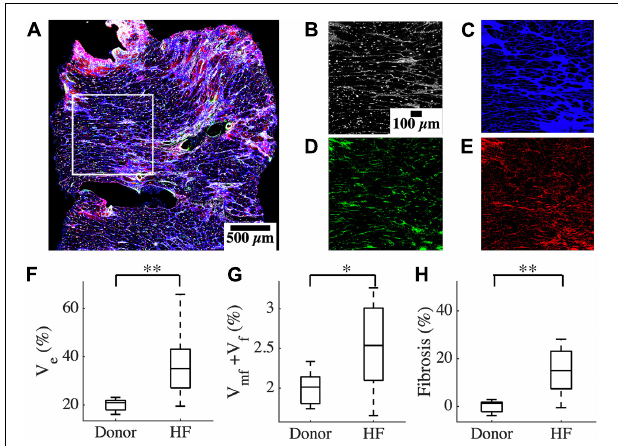
FIGURE 1 | Characterization of human cardiac tissue fibrosis at a microscopic scale. (A) Overlay of different fluorescent signals for analysis of fibrosis in an heart failure (HF) tissue sample. The white box marks the 1 mm 2 region of interest in this sample. The signals are separated and magnified in panels (B–E) . (B) DAPI signal, (C) WGA signal, (D) α -SMA, and (E) vimentin. (F) V e based on processed WGA signal, and (G) V f + V mf processed from DAPI,